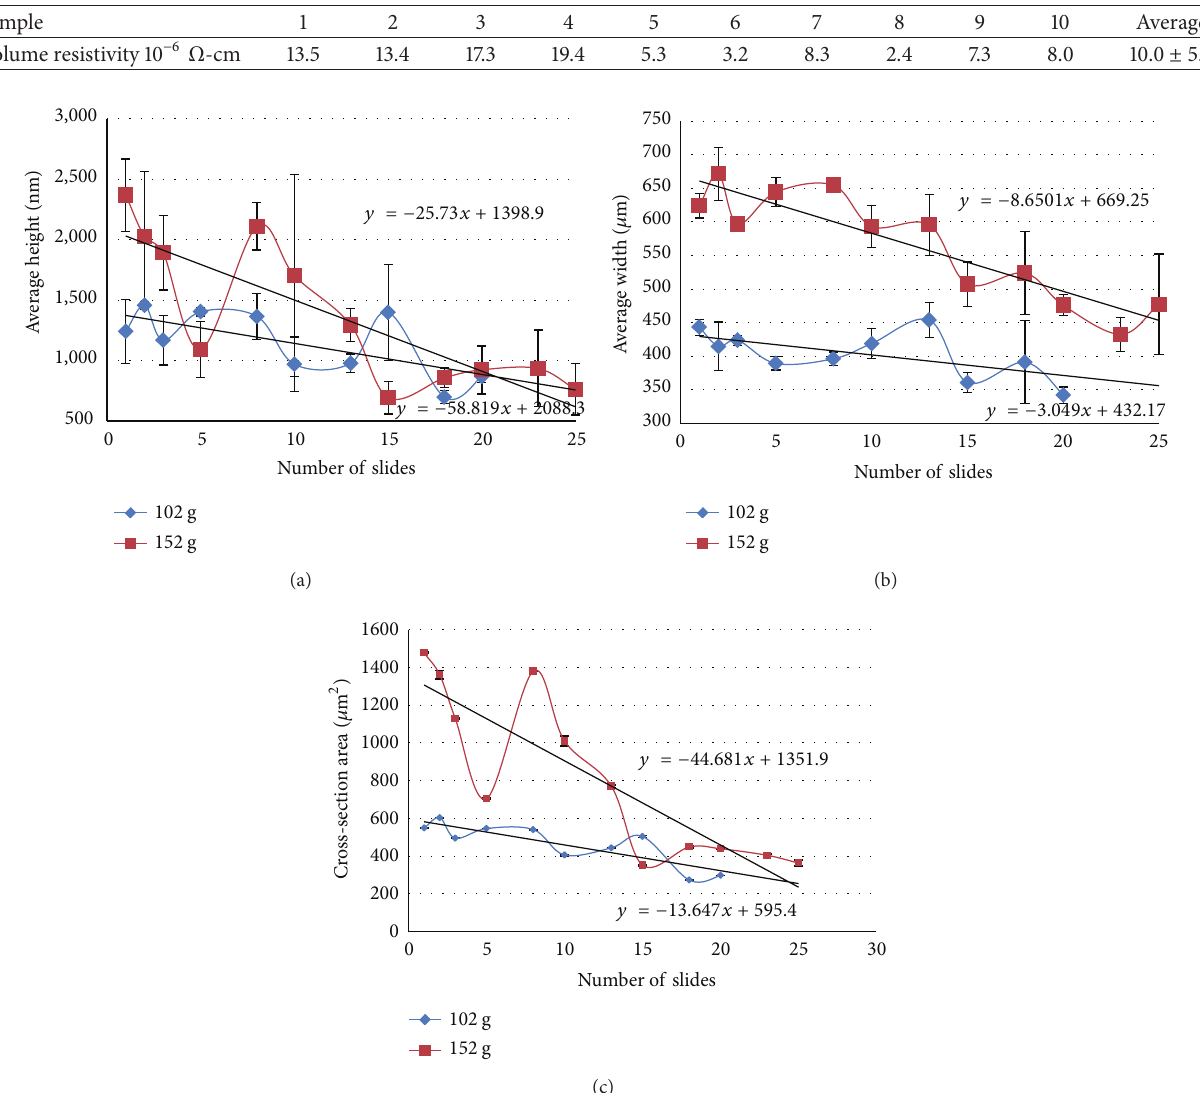
Figure 4: Results of the stamp method to fabricate IDE: (a) average height; (b) average width; and (c) cross-section area of finger in IDE versus the sequence number of